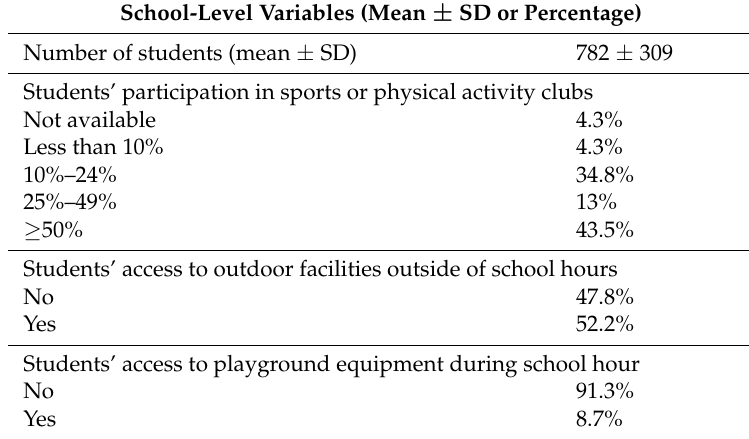
Table 2. Descriptive statistics for variables at the school level (level 2) ( n = 23).